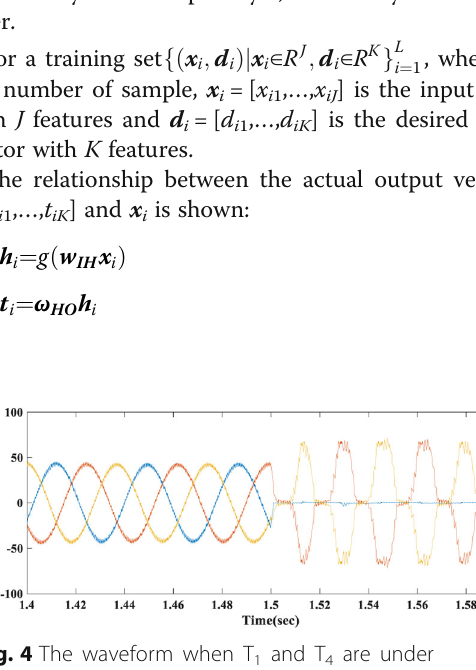
Fig. 2 The waveform when T 1 is under open-circuit fault